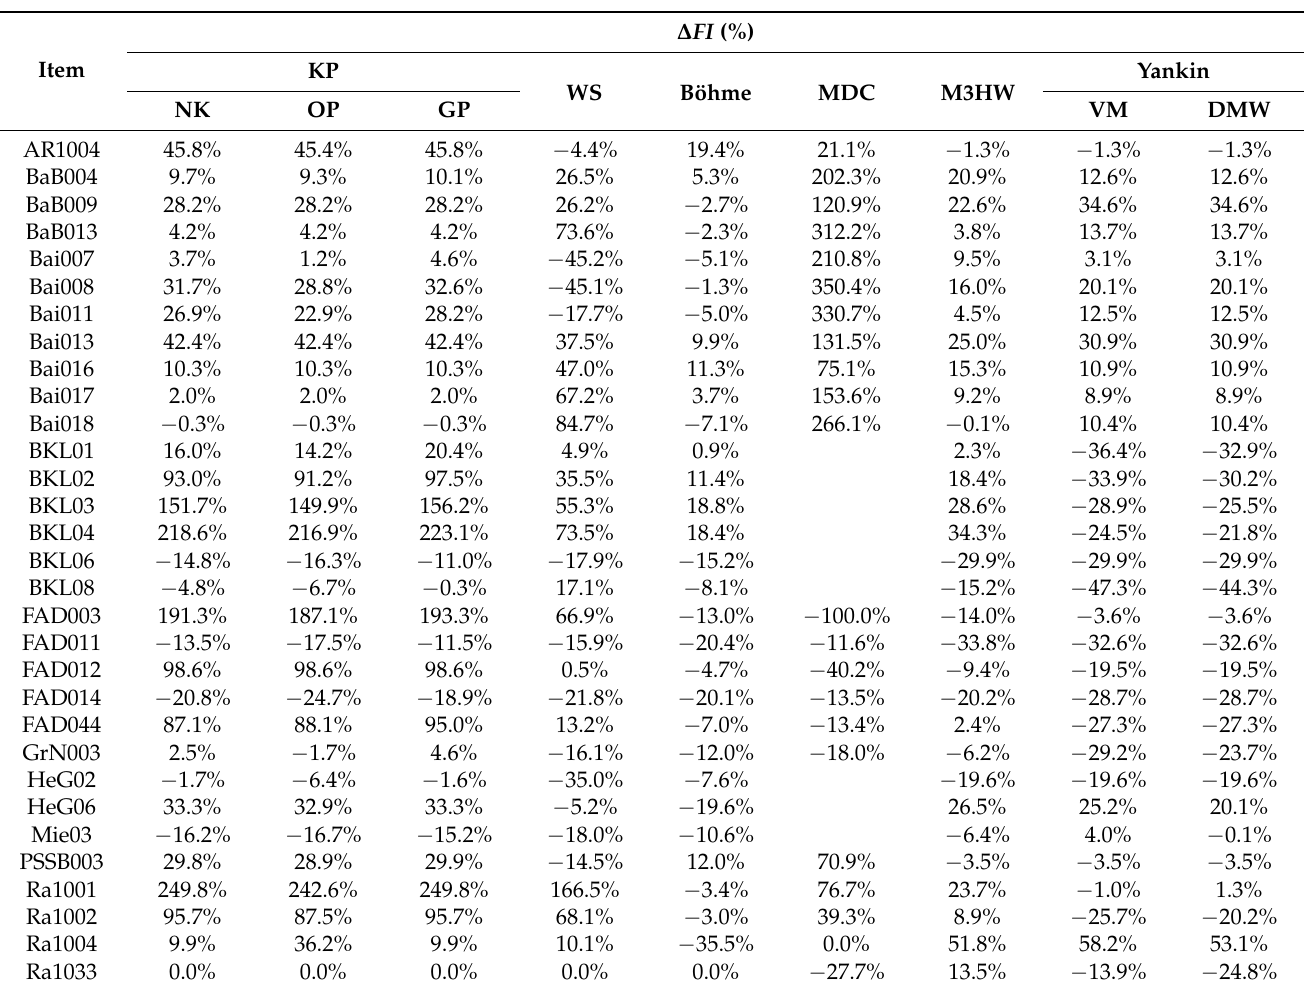
Table 5. The response of evaluated new multiaxial fatigue strength criteria to the tension–torsion load cases from AMSD25 data set. The void cells in the MDC column mark the load cases run in the staircase scheme, which does not provide material parameters required by the MDC criterion for its